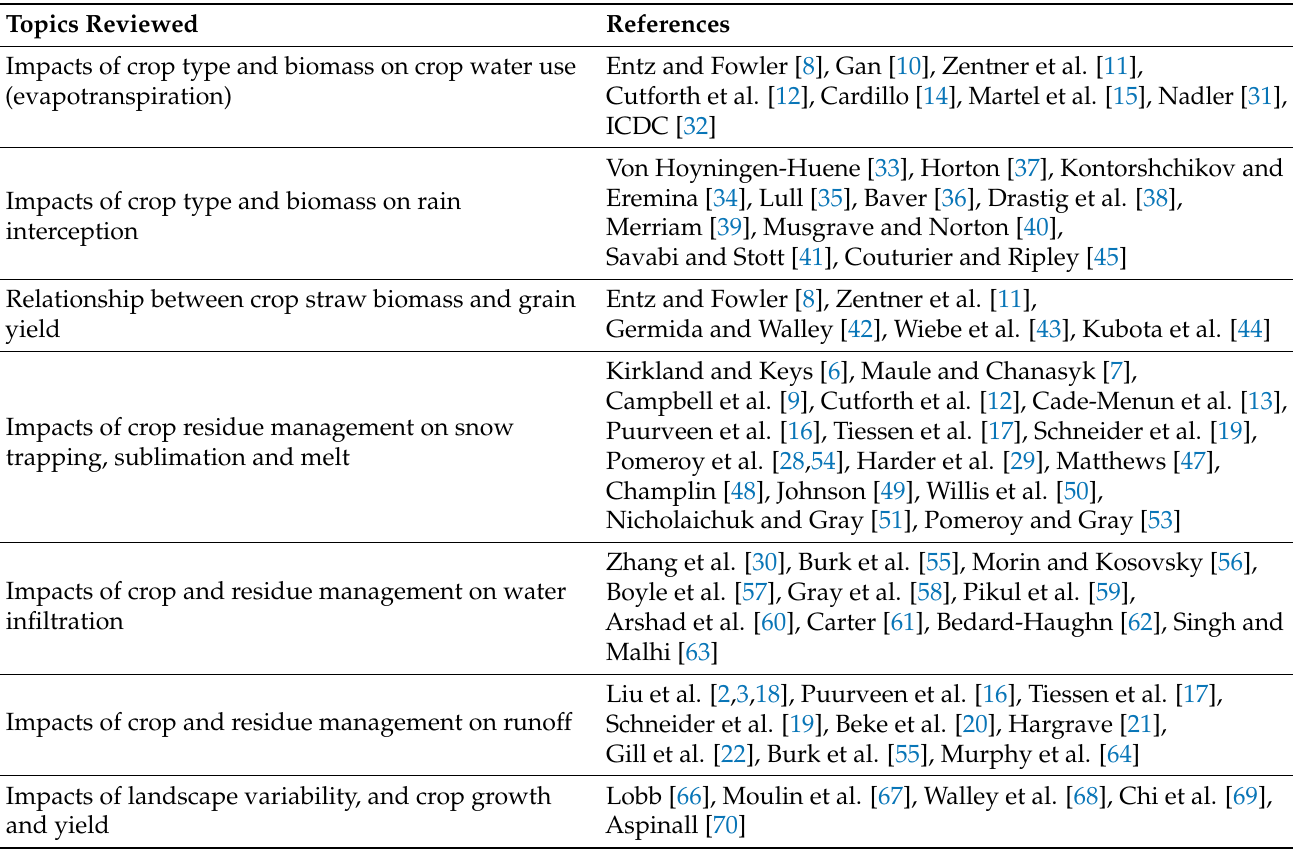
Table A1. Summary of papers reviewed for different topics.